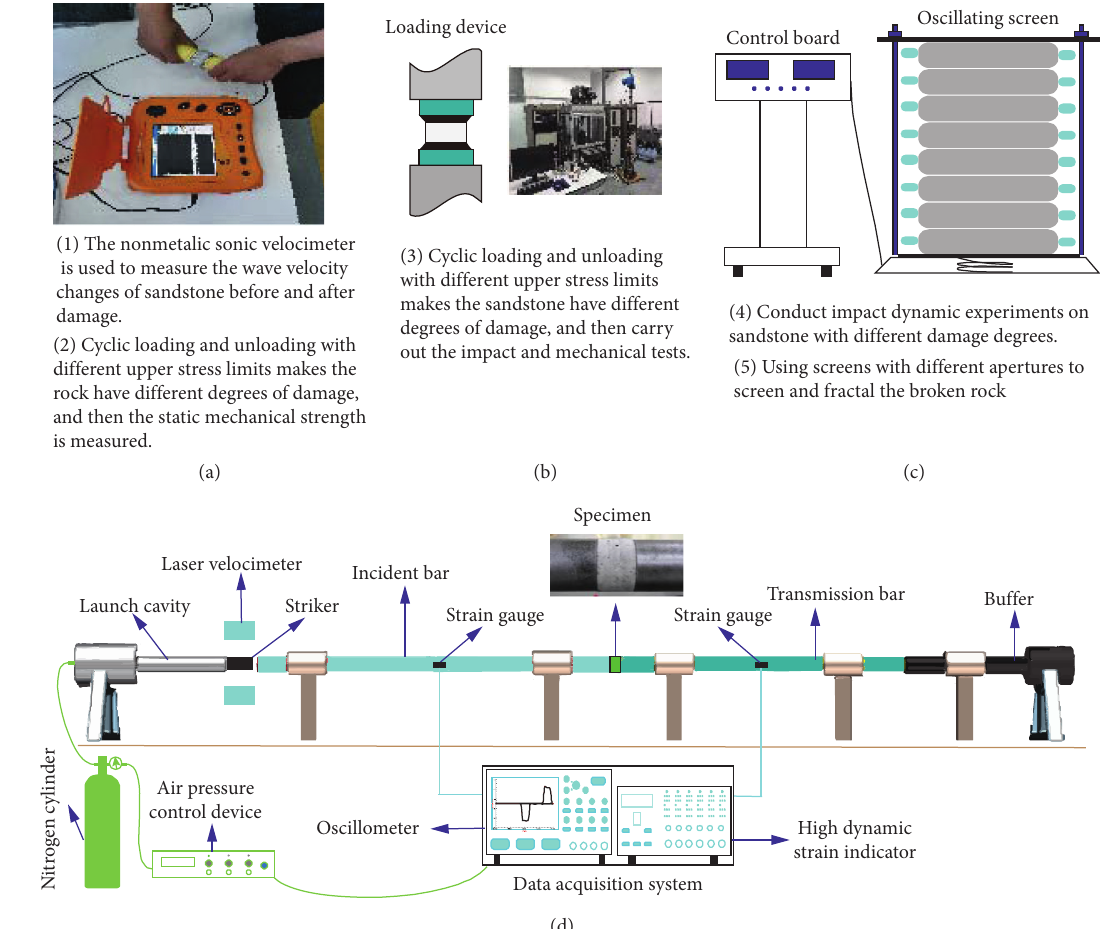
Figure 2: Experimental device and test